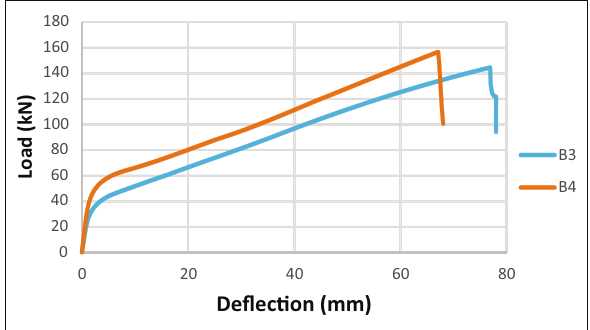
Figure 9: Load – de fl ection curve for specimens beams B3 and B4.